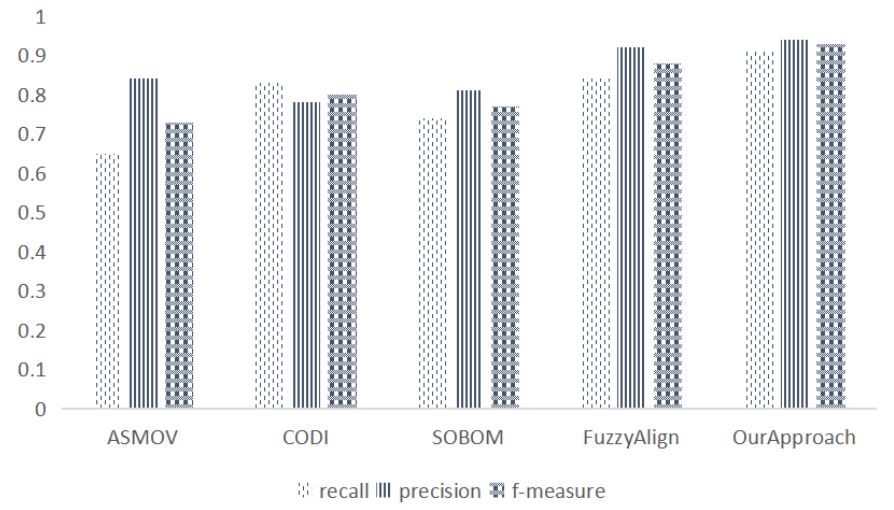
Figure 10. Comparison of Our Approach and the Advanced Sensor Ontology Matching Systems on MMI-SSN matching task.